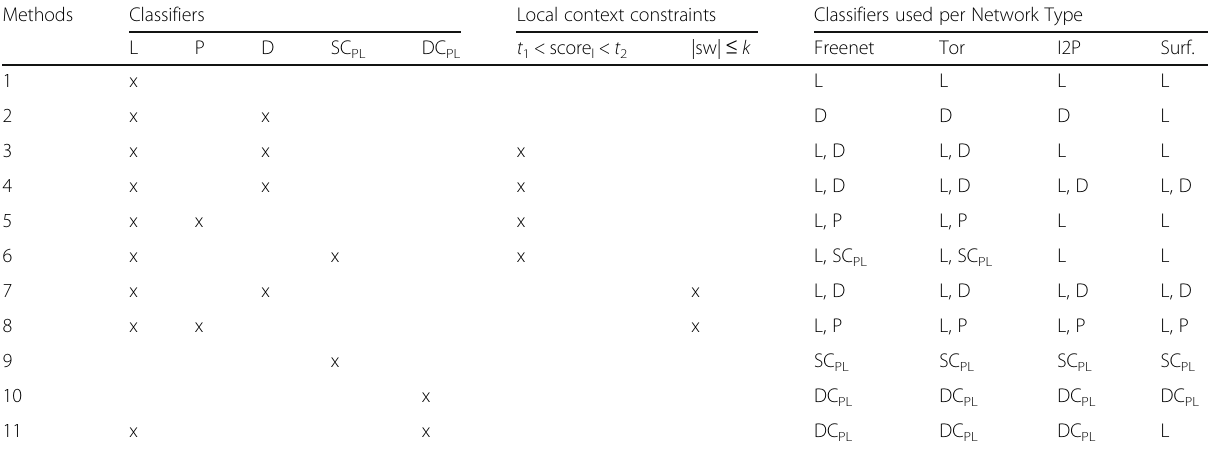
Table 1 Summary of the 11 hyperlink selection methods proposed. The table lists the classifiers involved, the local context constraints (where applied), and the network type where each classifier is applied for each method under consideration